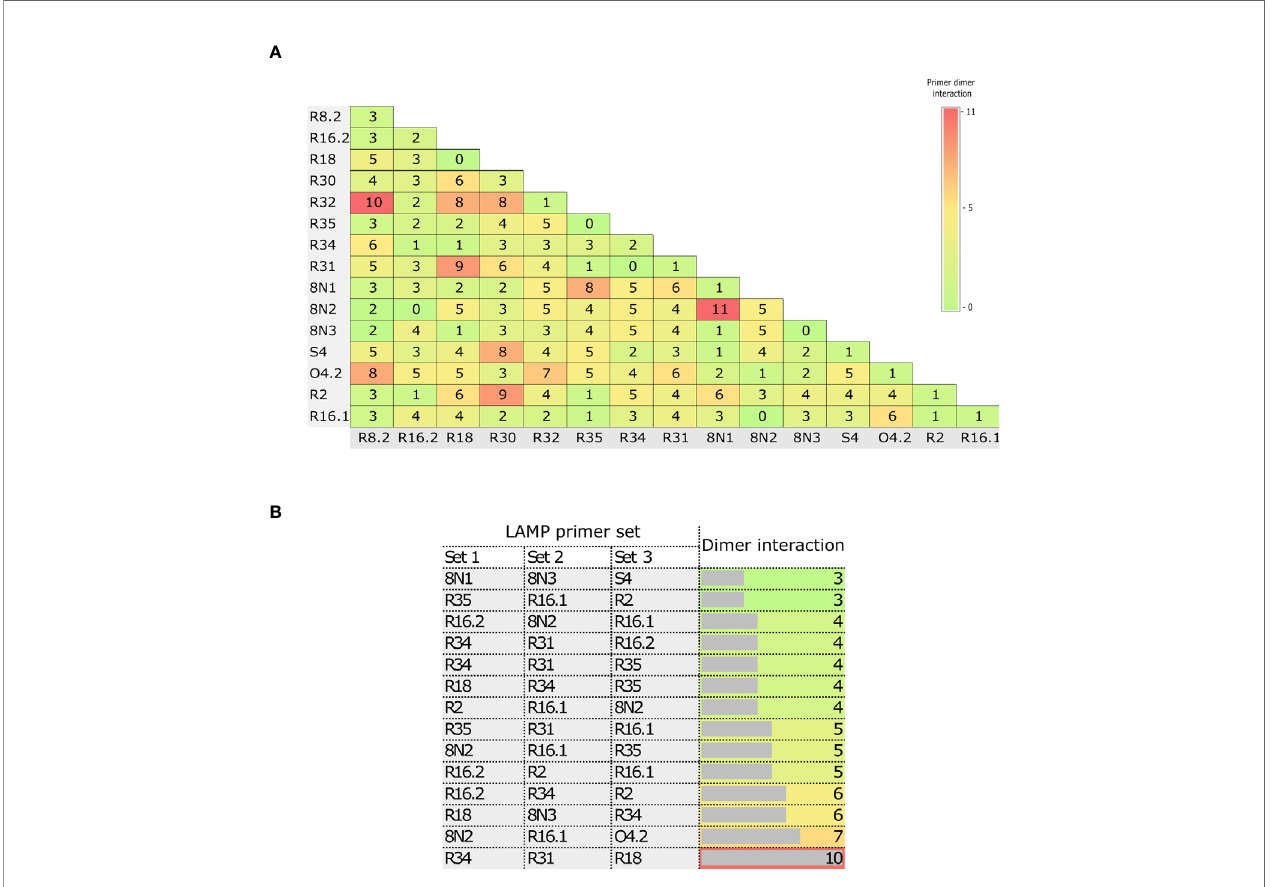
FIGURE 3 | Matrix of the numbers of primer dimer interactions within and between LAMP primer sets. Dimer interactions within primer sets and between two primer sets (A) , and between three primer sets (B)